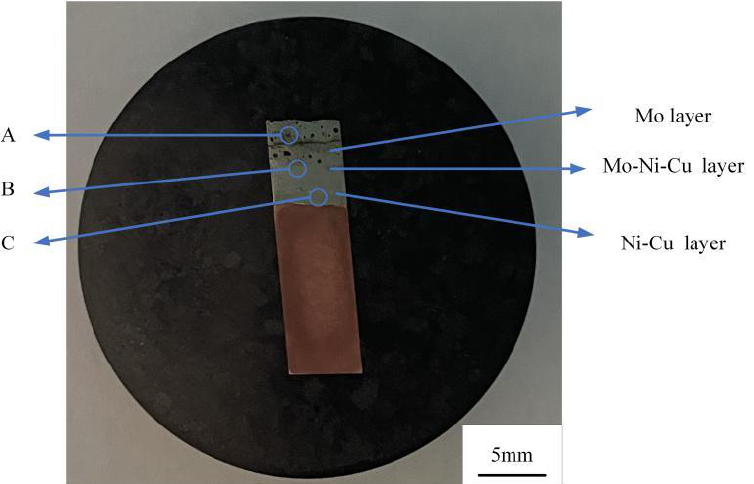
Figure 4. Macro Morphology.